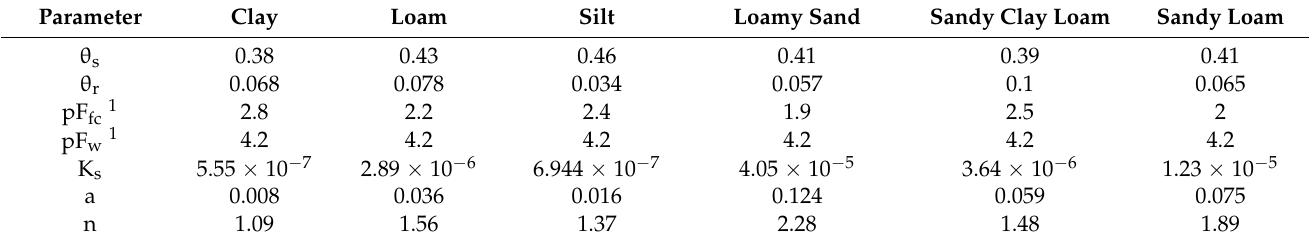
Table 1. Soil type, saturated moisture content ( θ s , cm 3 /cm 3 ), residual moisture content ( θ r , cm 3 /cm 3 ), suction at field capacity (pF fc ), suction at wilting point (pF w ), saturated hydraulic conductivity (K s , m/s), empirical constants in Van Genuchten formulas a (cm − 1 ) and n (-), used in the hydrological model of Lake Zazari